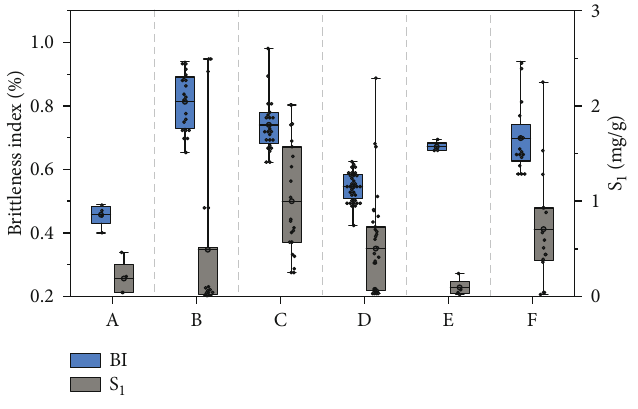
Figure 11: Brittleness index and S of the di ff erent 1 Table 3: Correlation analysis of clay, felsic, and calcareous mineral contents and logging curve for well B11x. Mineral composition CAL SP GR AC CNL DEN Clay minerals 0.41 Felsic minerals 0.48 Calcareous minerals -0.46 0.33